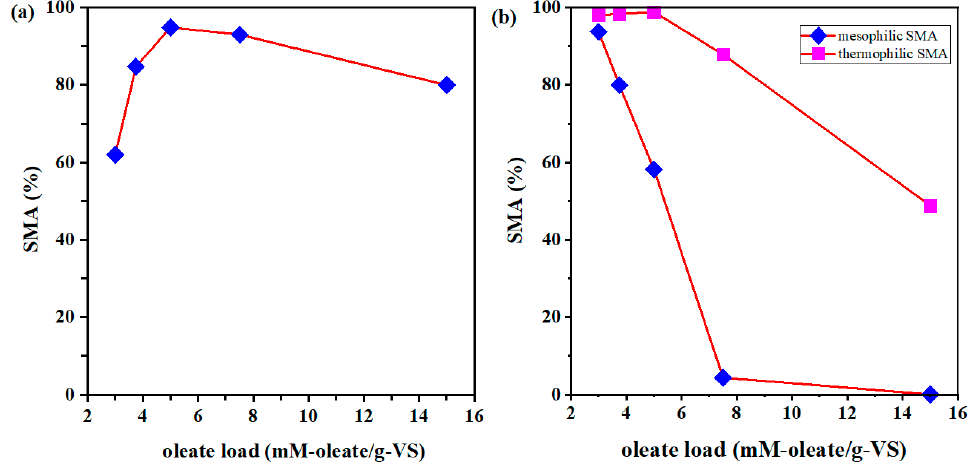
Figure 4. The relationship between oleate loads and SMA: ( a ) acetoclastic SMA in mesophilic sludge, ( b ) hydrogenotrophic SMA in mesophilic and thermophilic sludge.